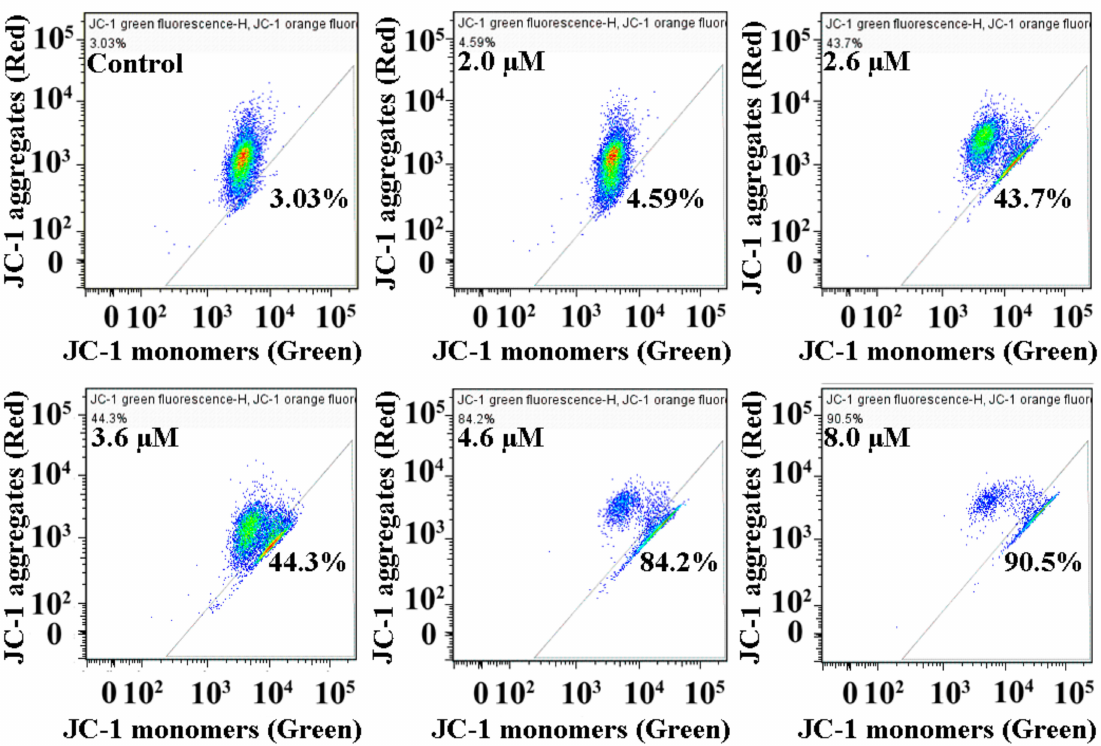
Figure 6. The collapse of mitochondrial membrane potential in MGC80-3 cells treated with Cu(II) complex 1 for 24 h, as determined by JC-1 staining.